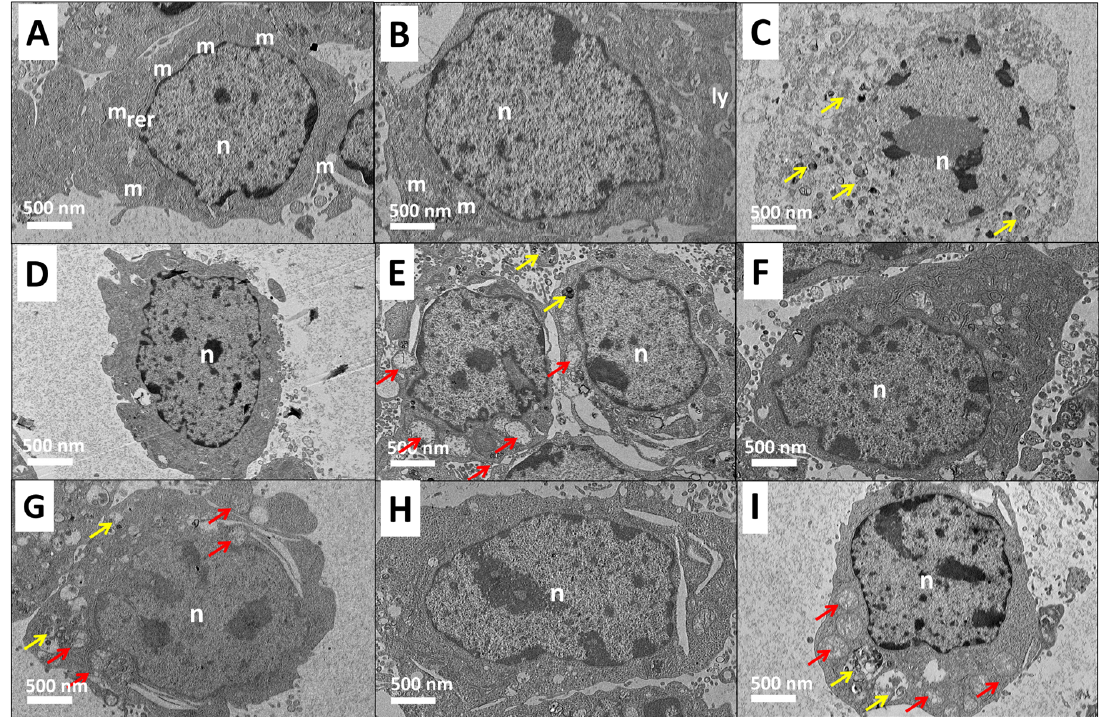
Figure 2. High-resolution transmission electron microscopy (HRTEM) micrographs of 3T3 mouse fibroblast cells of control ( A ) at 0 h, ( B ) at 48 h, and treated groups of 1 mg/mL active ingredient of ( C ) late apoptosis of dazomet ( D ) healthy cell of hexaconazole, ( E ) early apoptosis of hexaconazole, ( F ) healthy cells of CHEN, ( G ) early apoptosis of CHEN, ( H ) healthy cells of CDEN, and ( I ) early apoptosis of CDEN, at 48 h exposure, where n is a nucleus, m is mitochondria, ly is lysosome, and rer is rough endoplasmic reticulum. The red arrow indicates swollen mitochondria and the yellow arrow indicates condensed vacuoles. Magnification 1500×.